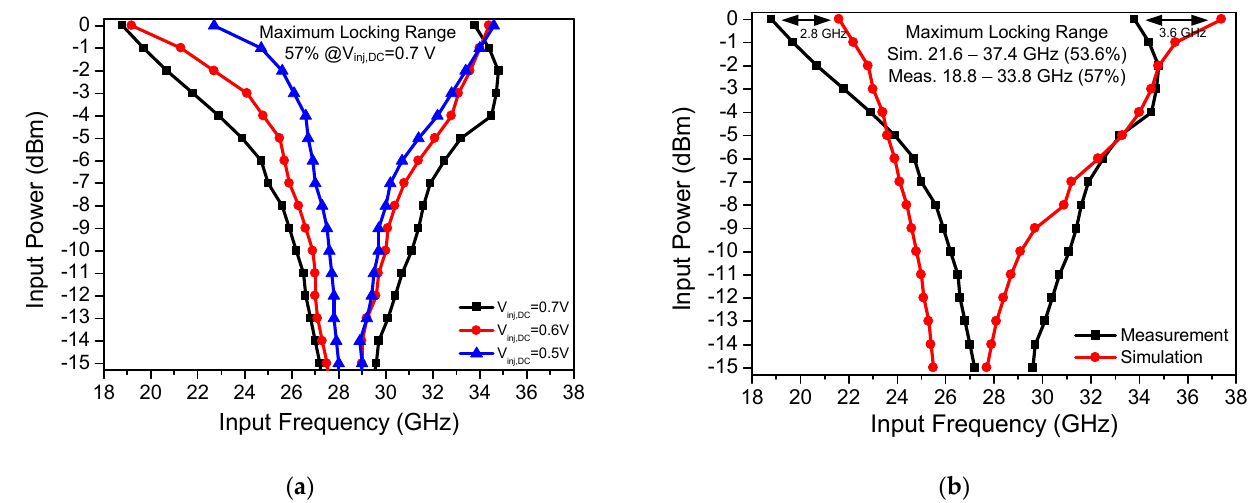
Figure 12. ( a ) Measured locking range results of the proposed CR-ILFD with different V inj,DC ; ( b ) measured and simulated locking range results of the proposed CR-ILFD.